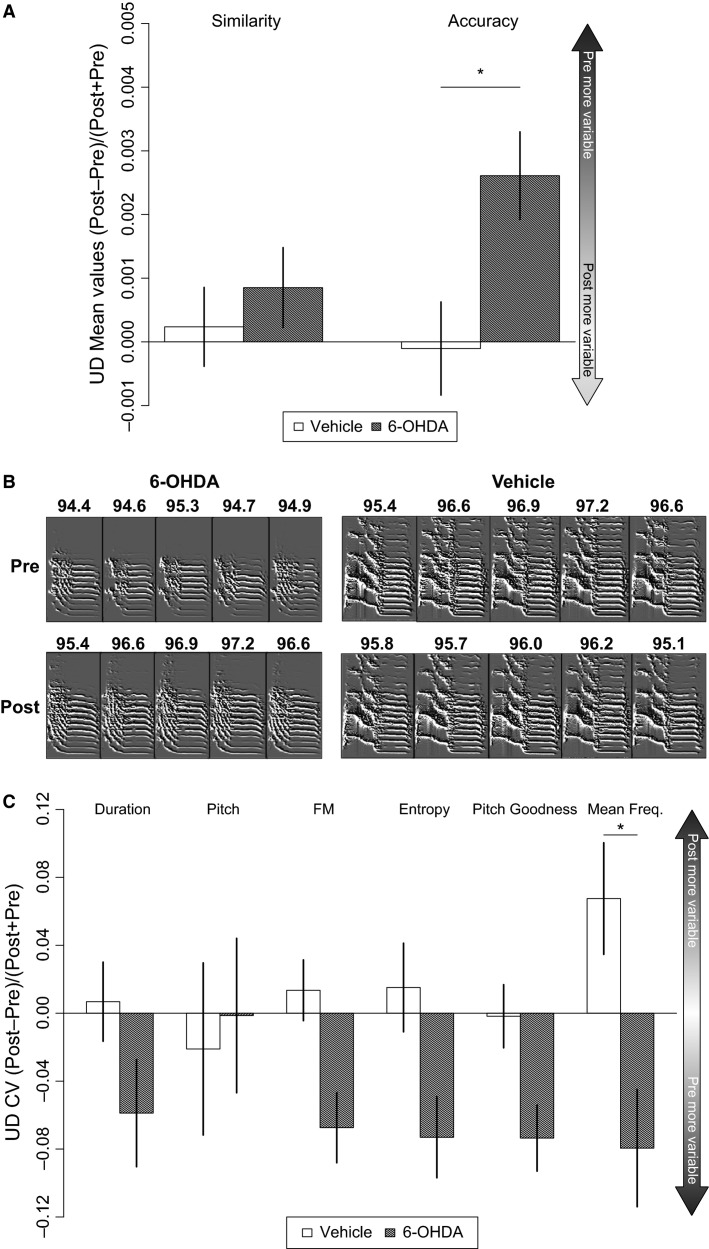
UD features become less variable with 6-OHDA injection in Area X. Effect sizes for the 6-OHDA versus the vehicle condition display the median score with standard error bars from all syllables for each bird. (A) Mean syllable self-accuracy, denoted by the higher bar, is significantly greater post-6-OHDA injection (*) compared to vehicle-injected birds. Self-similarity is not affected by treatment. (B) Consecutive renditions of the same syllable pre versus post-6-OHDA injection or vehicle with mean accuracy scores. Following 6-OHDA injection, the syllable increases in self-accuracy over multiple renditions, not observed in vehicle-injected birds. (C) Duration, frequency modulation (FM), entropy, and pitch goodness show a trend for decreased variability in the post-6-OHDA injected birds compared to vehicle-injected controls. Variability in mean frequency (coefficient of variation, CV) is significantly less (*) following injection of 6-OHDA versus vehicle.